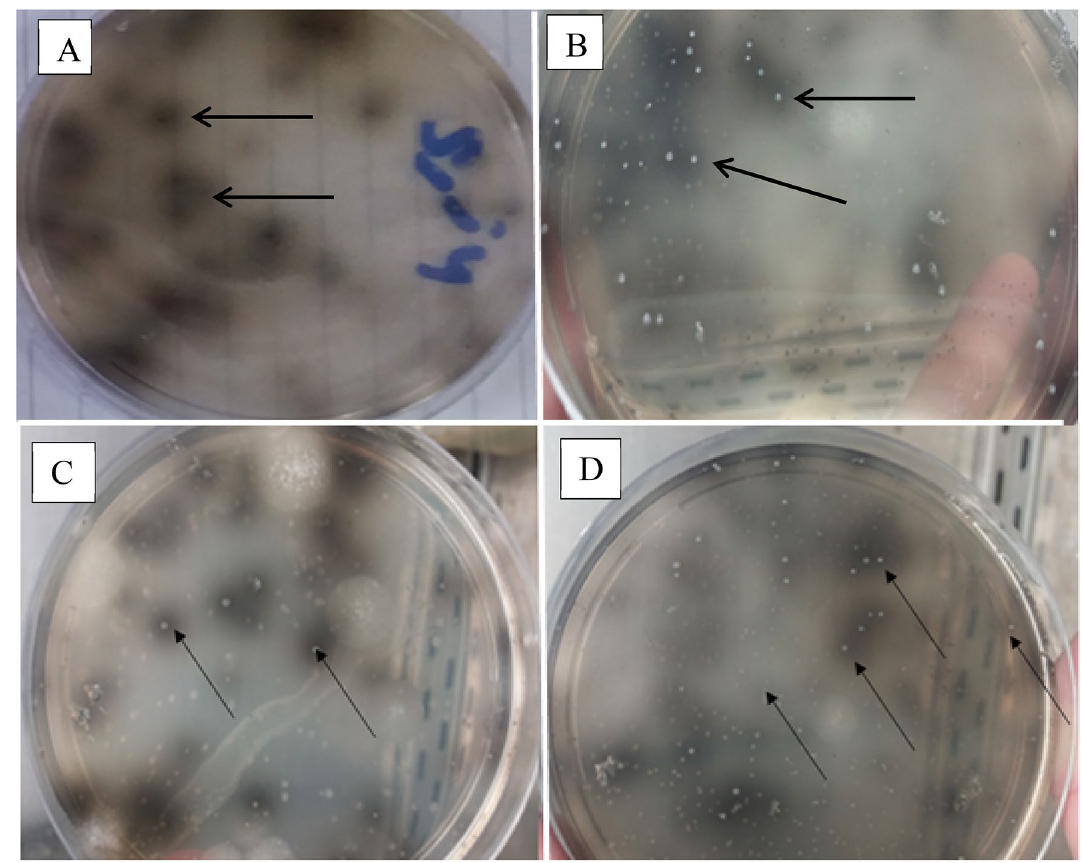
Figure 1. Selective isolation of metals reducing bacteria. ( A ) sample A1 cultured on Iron nitrate, ( B ) sample A4 cultured on Copper nitrate ( C ) sample A7 cultured on Cobalt nitrate ( D ) sample A8 cultured on Zinc nitrate.